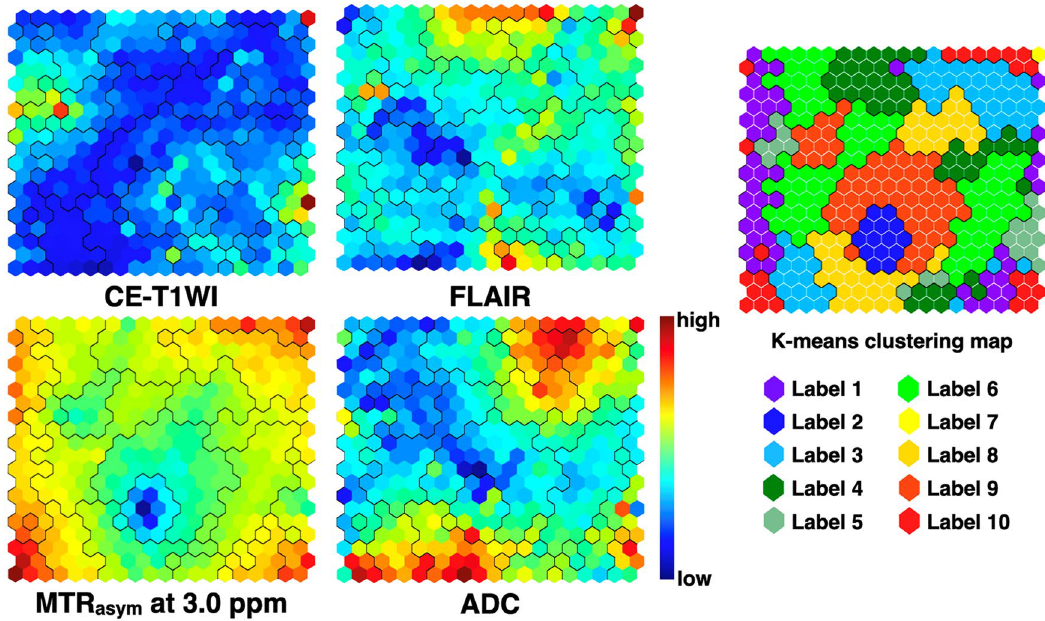
Figure 1. Component planes with a SOM for CE-T1WI, FLAIR, MTR asym at 3.0 ppm, and ADC colorized from blue to red according to each value, with red indicating a higher weight. The inter-class borderlines obtained by K-means clustering with K = 10 are shown on the SOM component planes as black lines between the nodes. Detailed profiles can be seen on the K-means clustering map from labels 1 to 10 shown at the far